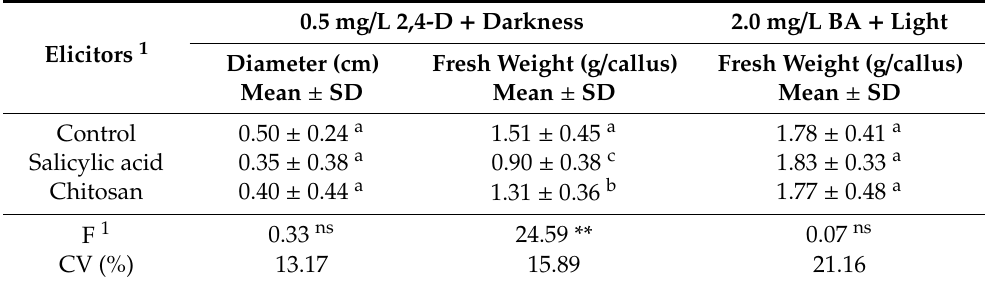
Table 4. E ff ects of the elicitors chitosan and salicylic acid (SA) on in vitro callus growth under darkness + 2,4-D and light +